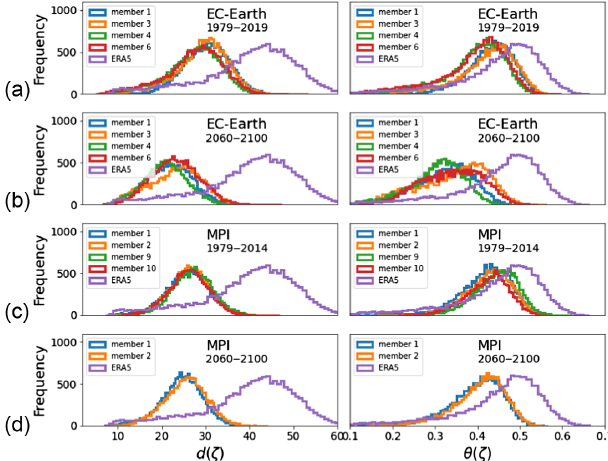
FIG. 9. Histograms of local dimension d ð ζ Þ and inverse of persistence θ ð ζ Þ for the temperature field in EC-Earth and MPI. (a),(b) Results for EC-Earth. (c),(d) Results for MPI. The analysis is performed for the temperature variable.